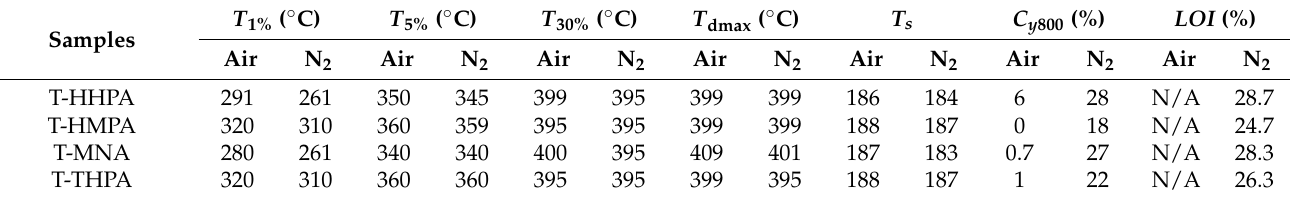
Table 5. Thermal properties of the epoxy-based